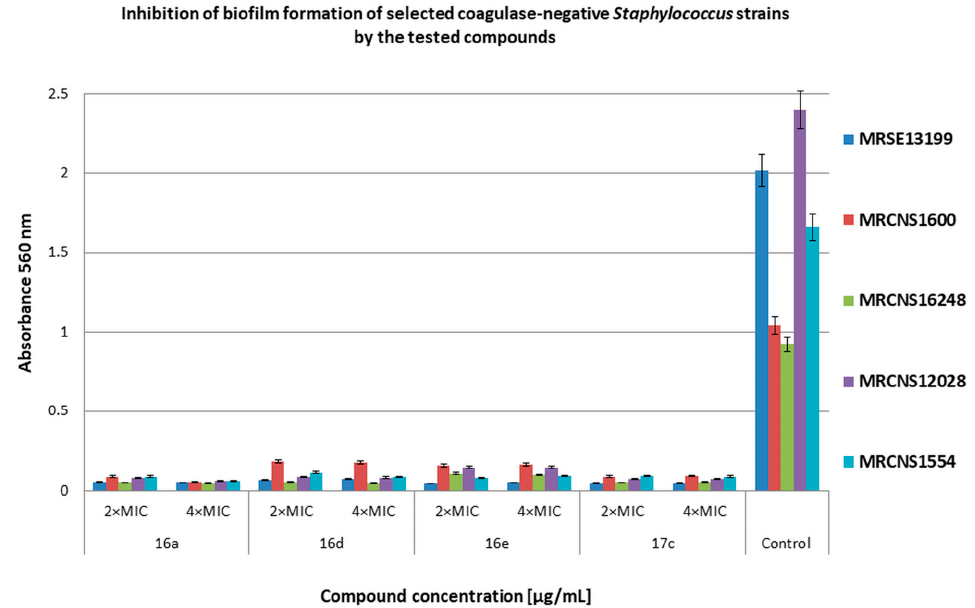
Figure 5. Inhibition of biofilm formation of selected methicillin-resistant coagulase-negative Staphylococcus (MRCNS) strains by the tested compounds. Bacteria without compounds were a control group. Double the minimum inhibitory concentration—2 × MIC, quadruple the minimum inhibitory concentration—4 × MIC. The results are presented as mean values ± standard deviation (±SD) from three independent experiments. Error bars represent standard deviation.